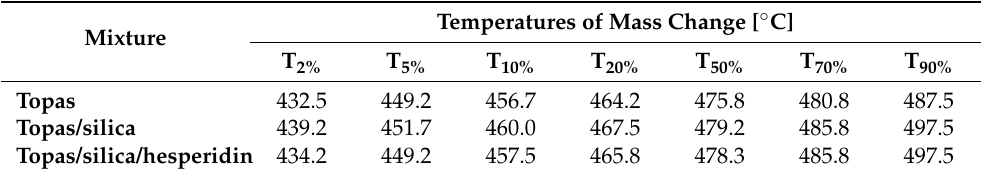
Figure 7. TGA curves of pure Topas and filled with silica and silica with hesperidin before aging that were heated from 25 to 800 ◦ C. Table 4. Temperatures of the mass change of tested samples, where T x% is a temperature at which the mass change is x% (2, 5, 10, 20, 50, 70, 90 %,